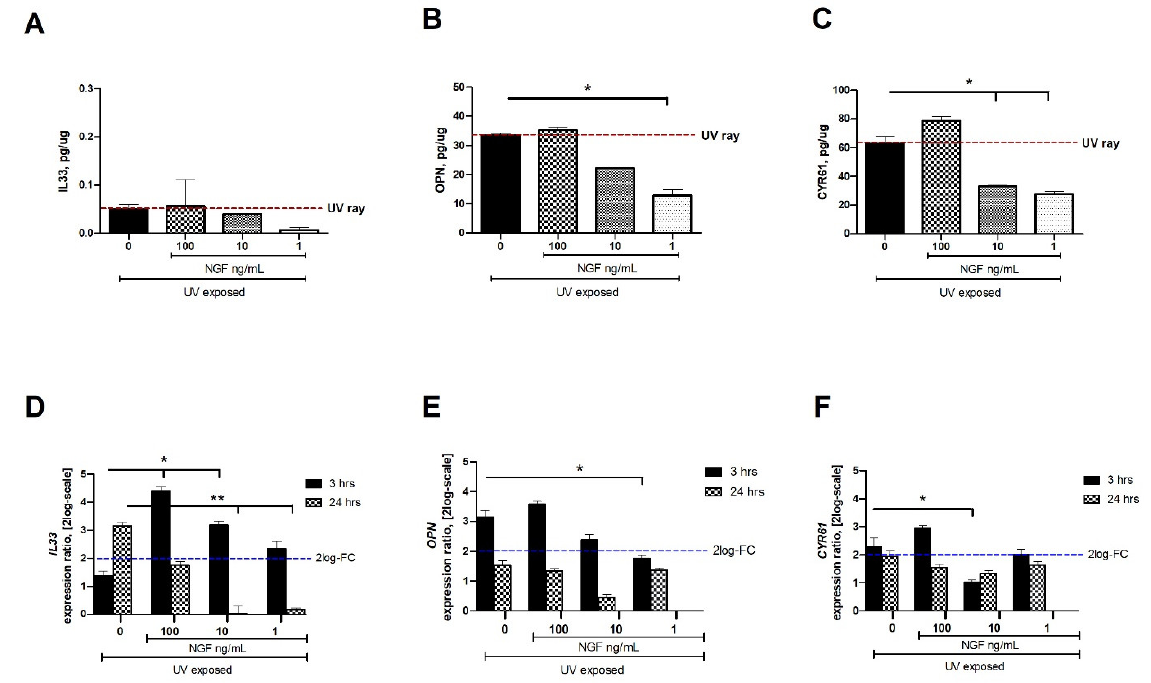
Figure 3. NGF supplementation affects IL33, OPN, and CYR61 expression in UV-exposed conjunctival FBs. Starved monolayers were UV-exposed either alone (0.05% FBS medium) or supplemented with increasing NGF doses (1 – 10 – 100 ng/mL). At specific time-points from exposure, conditioned media ( A – C ) and monolayers ( D – F ) were collected and analyzed (IL33, OPN, CYR61). UV exposure resulted in great release of cytokines and growth factor in conditioned media from UV-exposed conjunctival FBs, as compared to unexposed ones. The analysis of transcripts showed an increased mRNA expression for IL33 ( D ), OPN ( E ), and CYR61 ( F ) in UV exposed conjunctival fibroblasts at 3 and 24 h from exposure. NGF supplementation (1 – 10 – 100 ng/mL) counteracted this target gene expression. Data represent mean ± SEM for all groups. REST-ANOVA followed by Tukey–Kramer post hoc analysis highlighted the significant effects indicated in the graphics (* p < 0.05 and ** p < 0.01), with respect to UV exposure; red dashed lines pointing at UV exposure and blue dashed lines for 2log-FC PCR biological